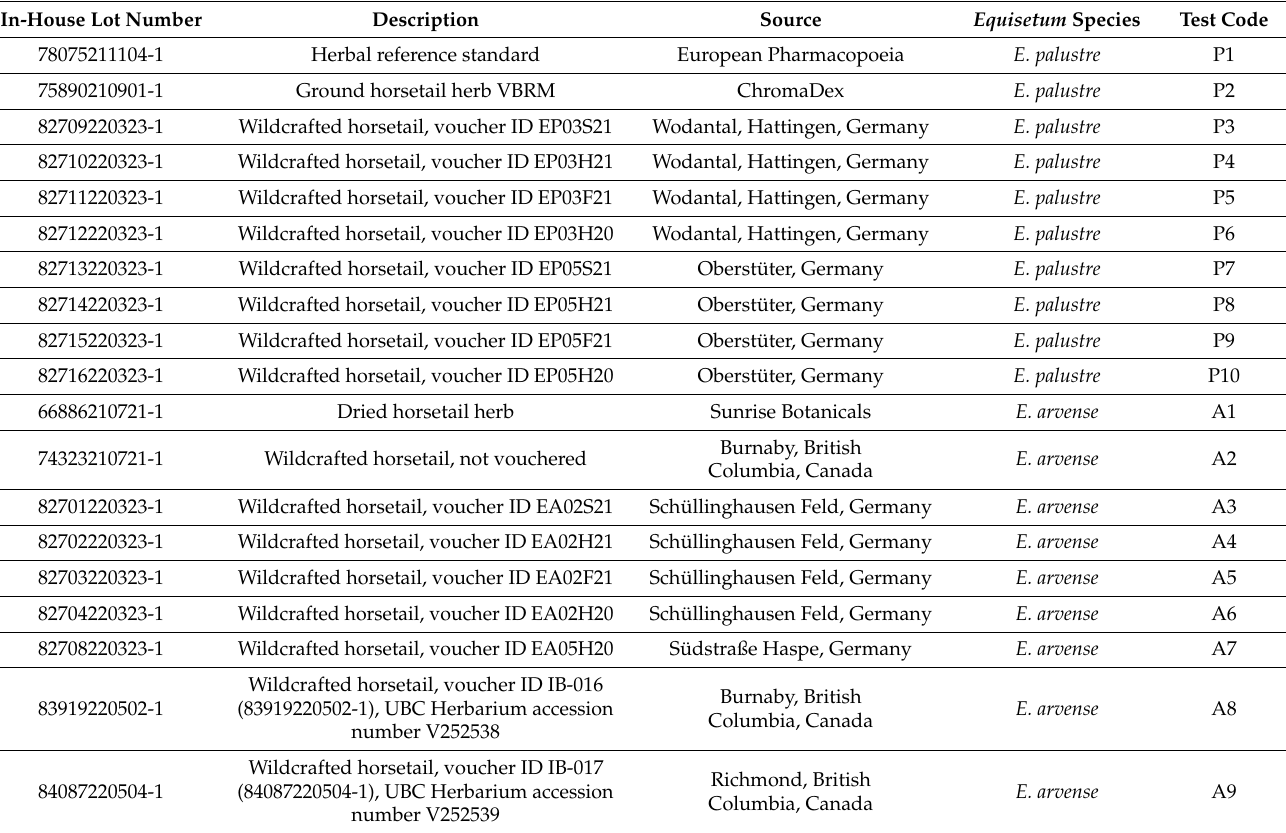
Table 5. Eight horsetail samples from varying sources were obtained and allotted a test code. The alphanumeric code using “P” refers to all E. palustre samples, while the code using “A” refers to all E. arvense